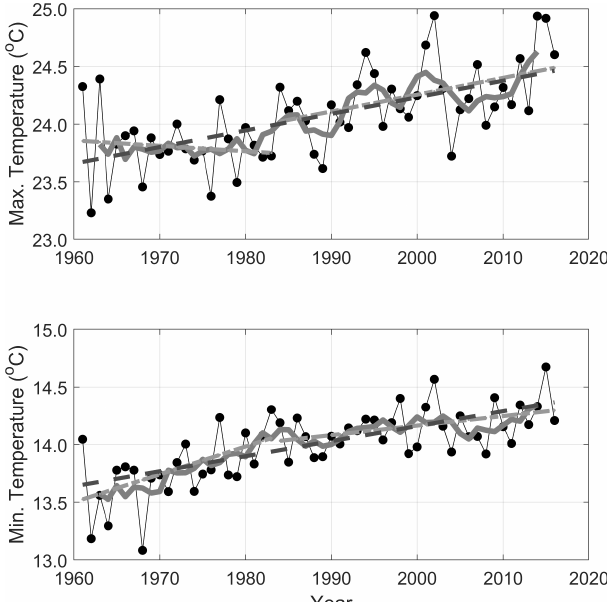
Figure 5. Annual mean variability of daily maximum and minimum air temperatures at 1.5m. Grey curves represent 5-year moving av- erages, light grey dotted lines are the result of trend analysis from 1961 to 1983 and from 1984 to 2016, and the dark grey dotted line represents the trend from 1961 to